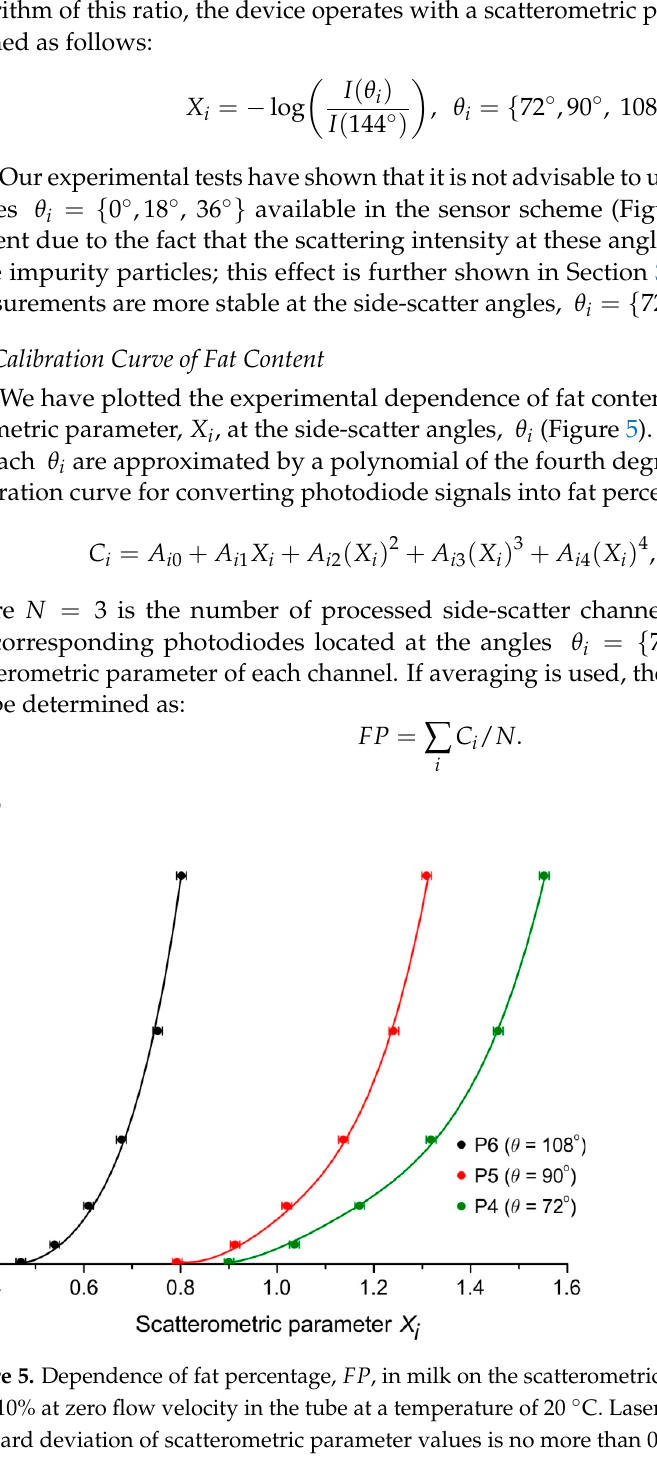
Figure 5. Dependence of fat percentage, 𝐹𝑃 , in milk on the scatterometric parameter, 𝑋 (cid:3036) , in the range 0.05–10% at zero flow velocity in the tube at a temperature of 20 °C. Laser wavelength is 532 nm. The standard deviation of scatterometric parameter values is no more than